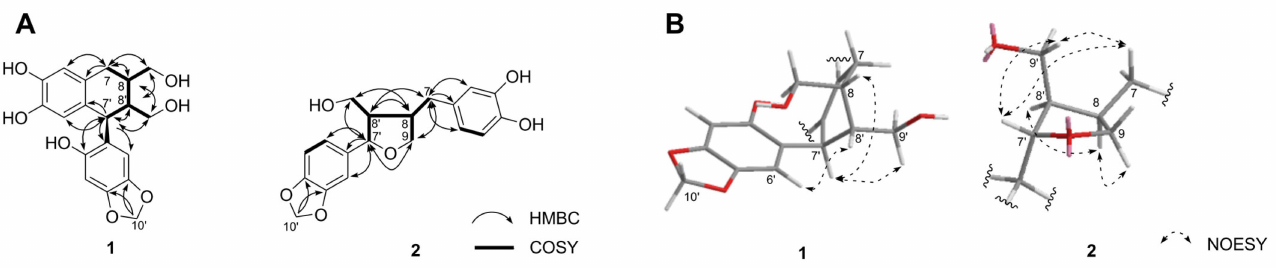
Figure 2. 1 H- 1 H COSY ( A ), key HMBC ( A ), and NOESY ( B ) correlations of 1 and 2